Question: Does the figure show an increasing or a decreasing trend?
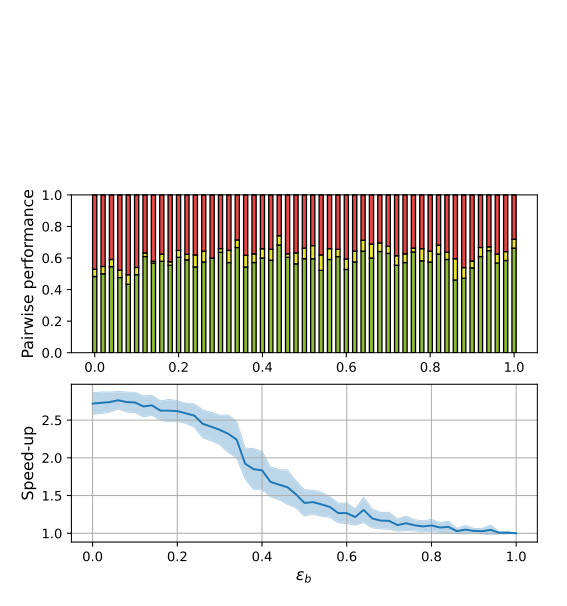
Answer: increasing